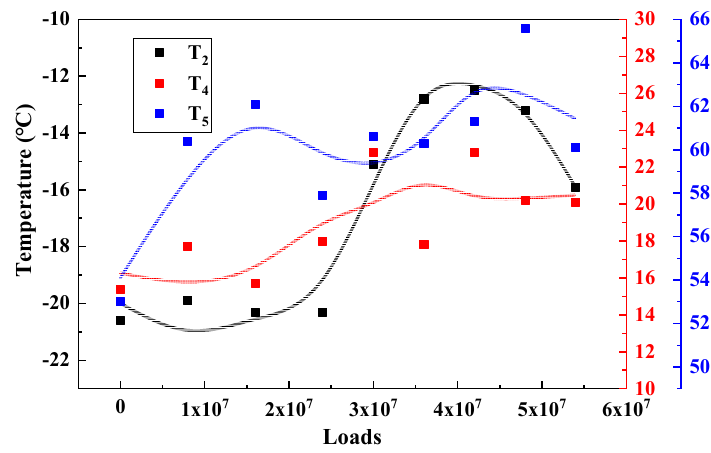
Figure 11. Characteristic temperature variation of STR18/19.